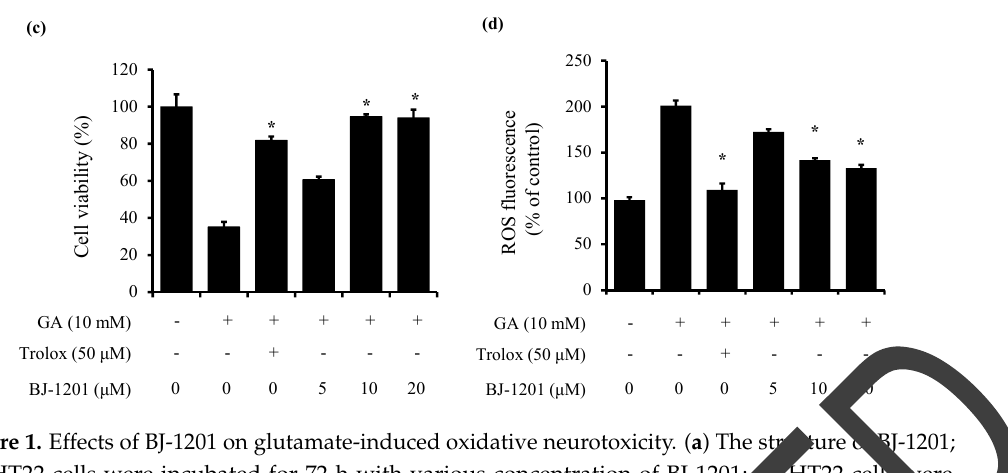
Figure 1. Effects of BJ-1201 on glutamate-induced oxidative neurotoxicity. ( a ) The structure of BJ-1201; ( b ) HT22 cells were incubated for 72 h with various concentration of BJ-1201; ( c ) HT22 cells were pre-treated with BJ-1201 for 12 h and then incubated for 12 h with glutamate (10 mM). Cell viability was measured by MTT assay; ( d ) Exposure of HT22 cells to glutamate increased ROS production. Each bar represents the mean ± S.D. of three independent experiments. * p < 0.05 compared with glutamate. Trolox (100 μ M) was used as the positive control.